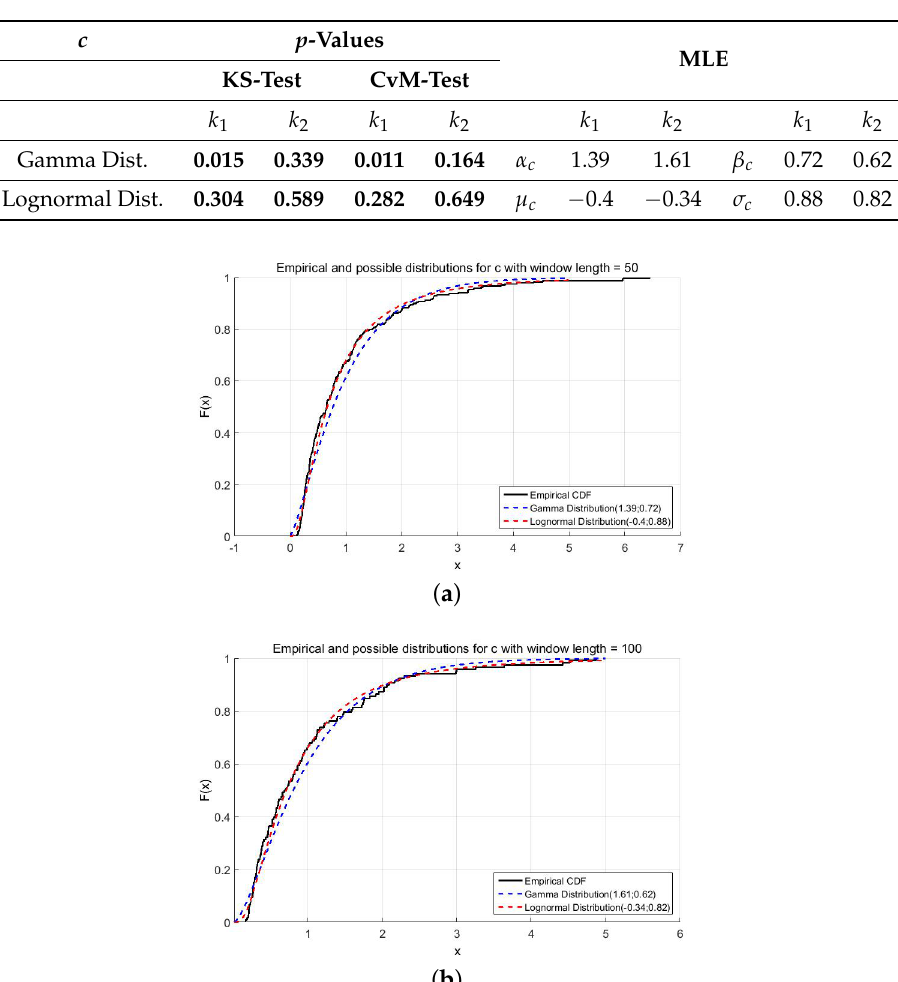
Figure 3. Possible and empirical distributions of c . ( a ) k 1 = 50; ( b ) k 1 = 100.